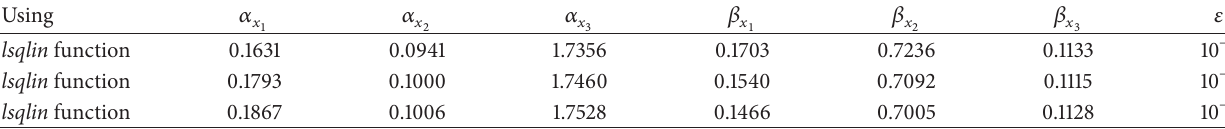
Table 5: Finding the left and right spreads.